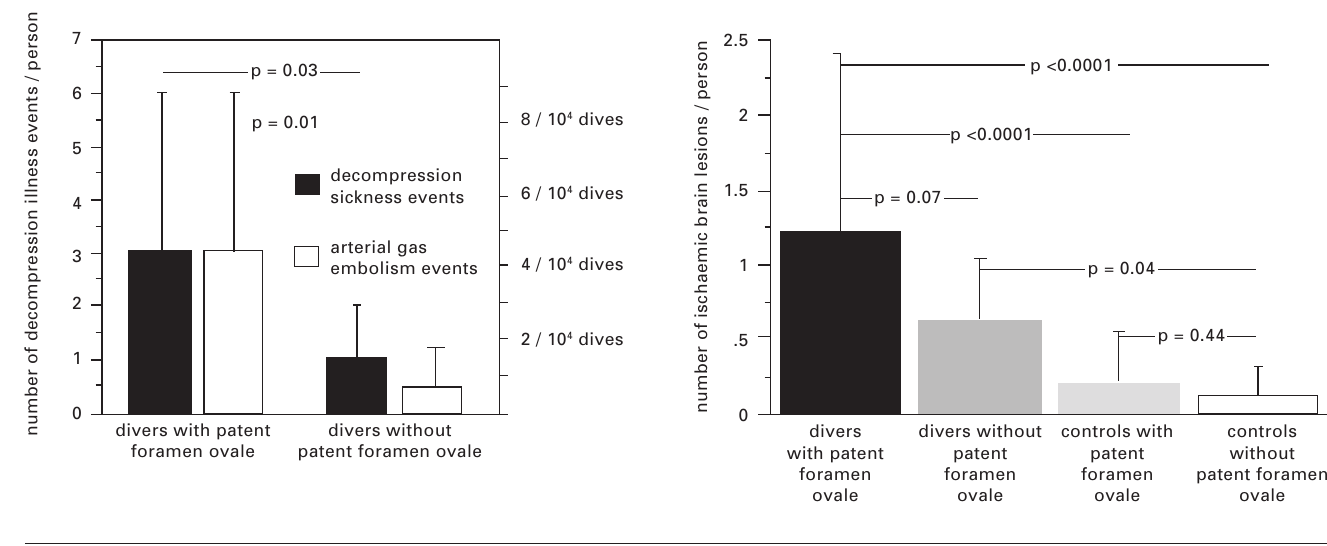
Figure 4 T 2 -weighted axial MR images of three divers without symp- toms and no history of decompression incidents. Large not well delineated hy- perintense lesions corresponding to ischaemic infarcts are seen in the periventricular and subcortial white mat- ter (arrows in panels A, B). Round or linear shaped hyperintensi- ties corresponding to Virchow-Robin- spaces are seen in (B) and (C)